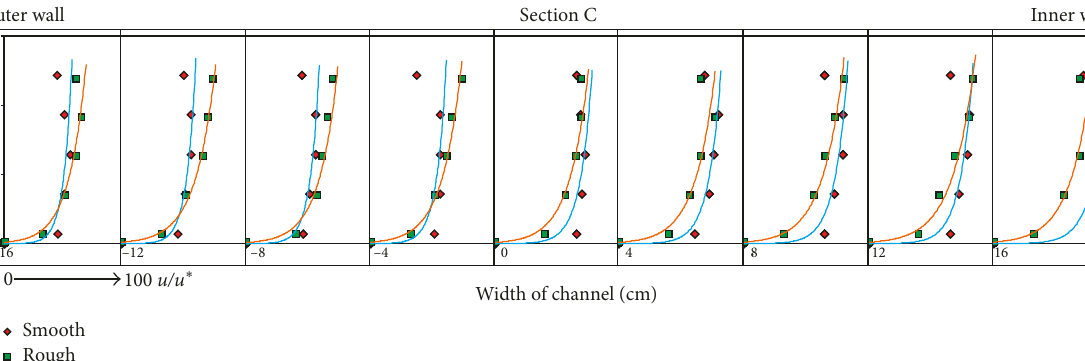
Figure 5: Comparison of velocity variation in section B.